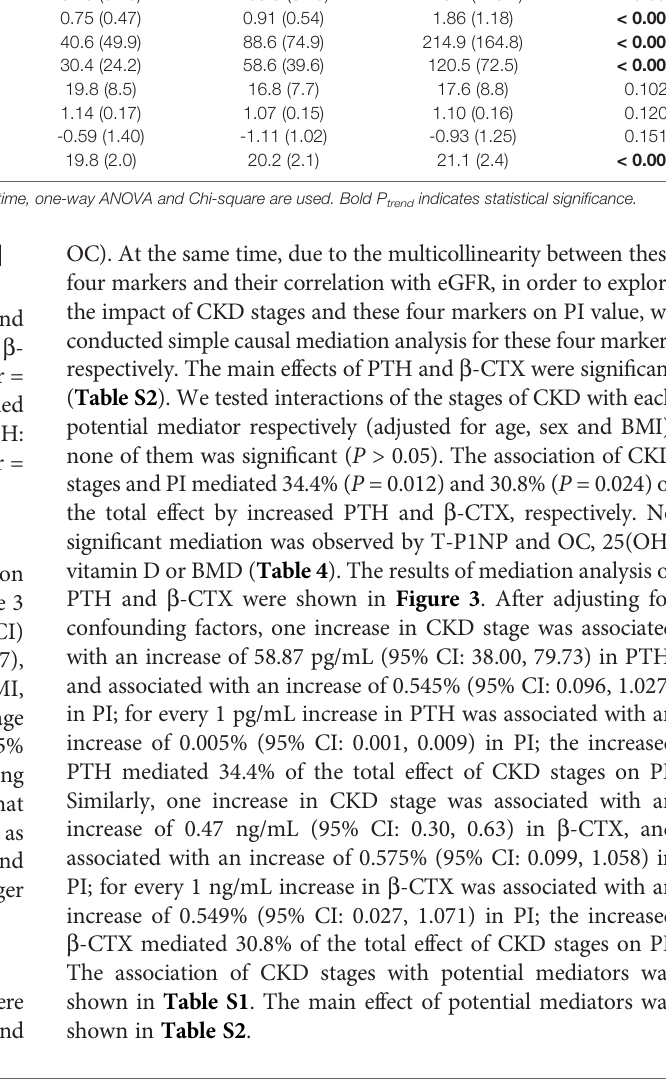
TABLE 2 | Adjusted correlation coef fi cients between PI, eGFR and potential mediators. PTH